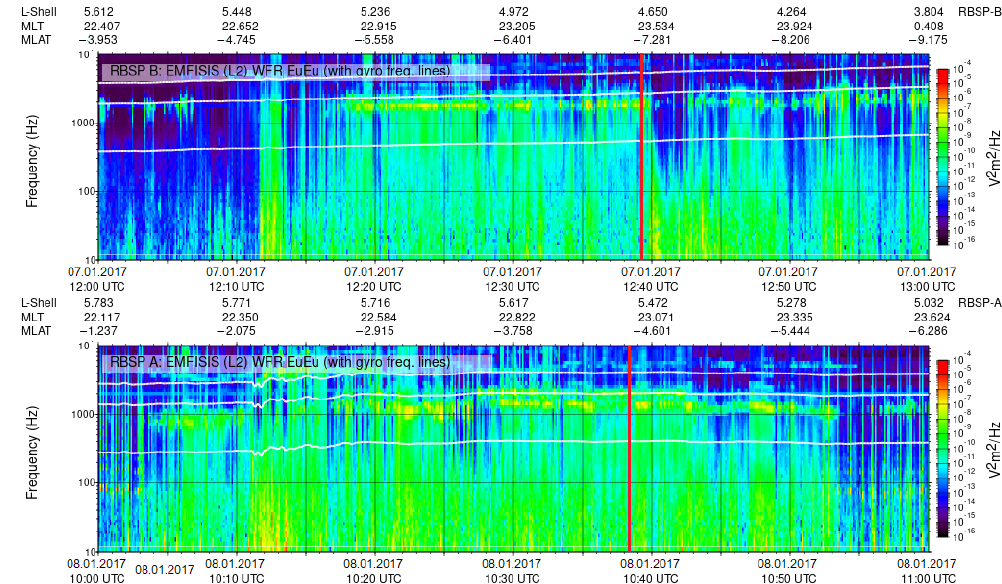
Figure 3. EMFISIS RBSP data during two TUS event measurements. Upper panel for 7 January 2017 12:39:14 UTC, lower–8 January 2017 10:38:19 UTC. White lines indicated electron gyro frequency f c (upper line), 0.5f c (middle line), 0.1f c (bottom line). Red vertical lines show the moments of TUS event